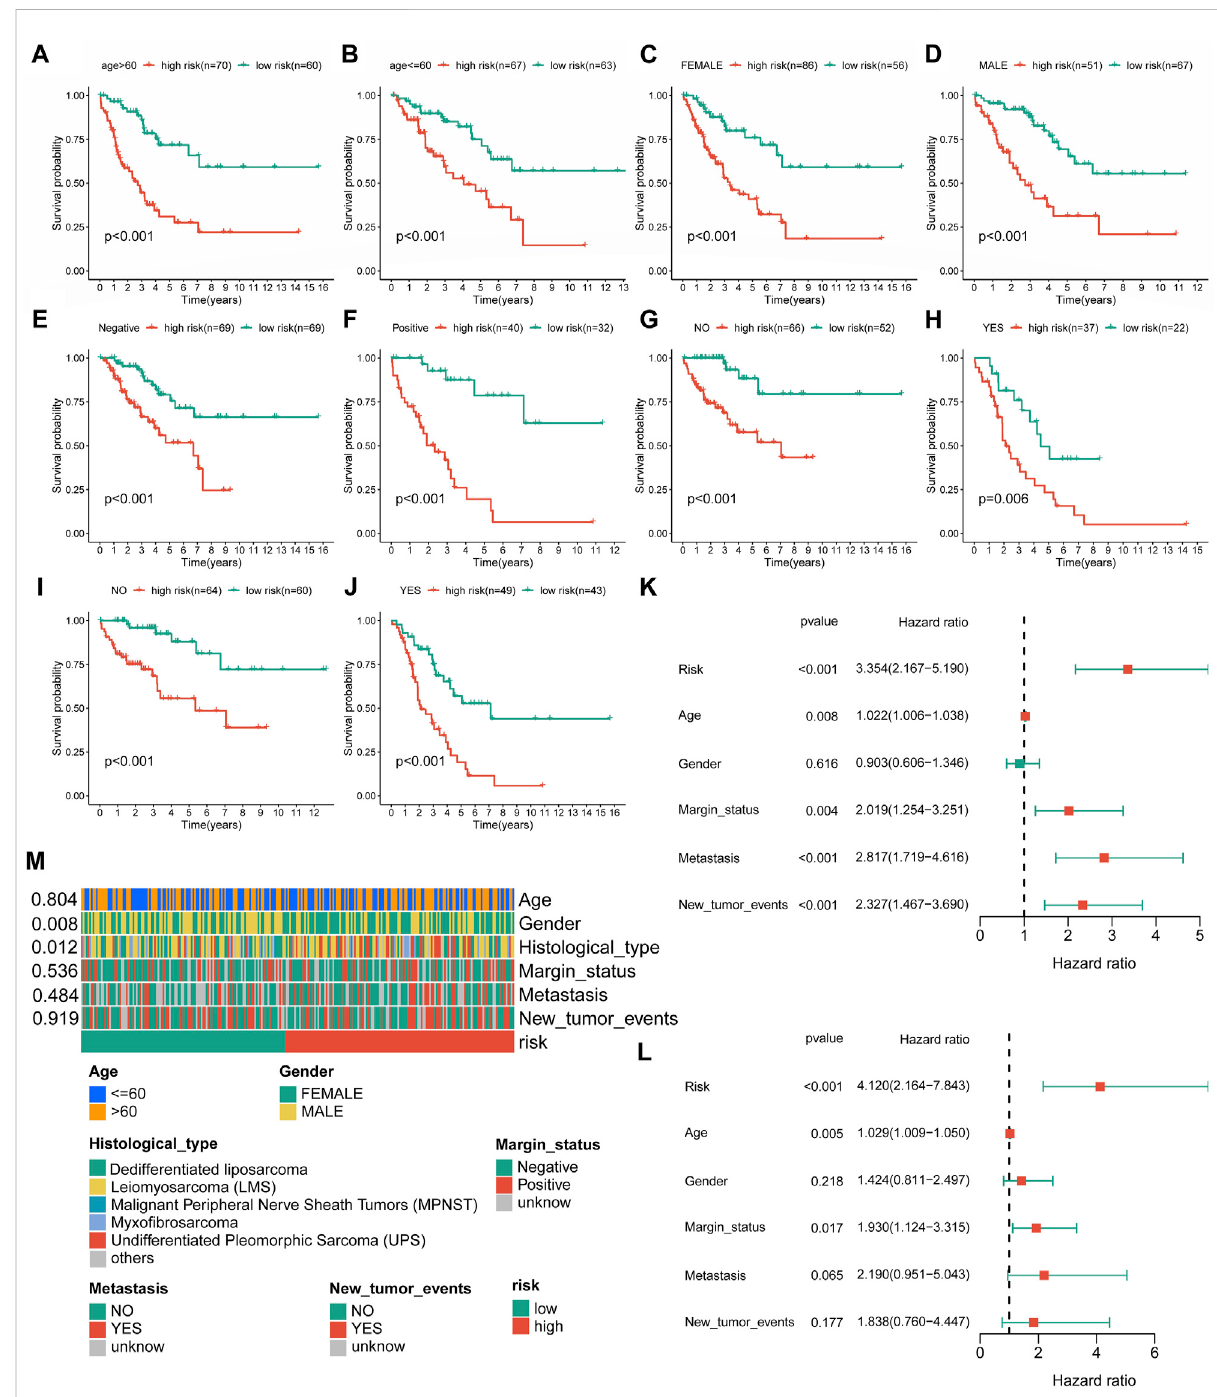
FIGURE 4 Independent prognostic value of the novel CRLncSig. (A – J) K – M survival curves is strati fi ed by Age, Gender, Margin status, Metastasis status, and New tumor events between the distinct groups. (K) The univariate Cox regression analysis. (L) The multivariate Cox regression analysis. (M) Association between the risk scores and clinical